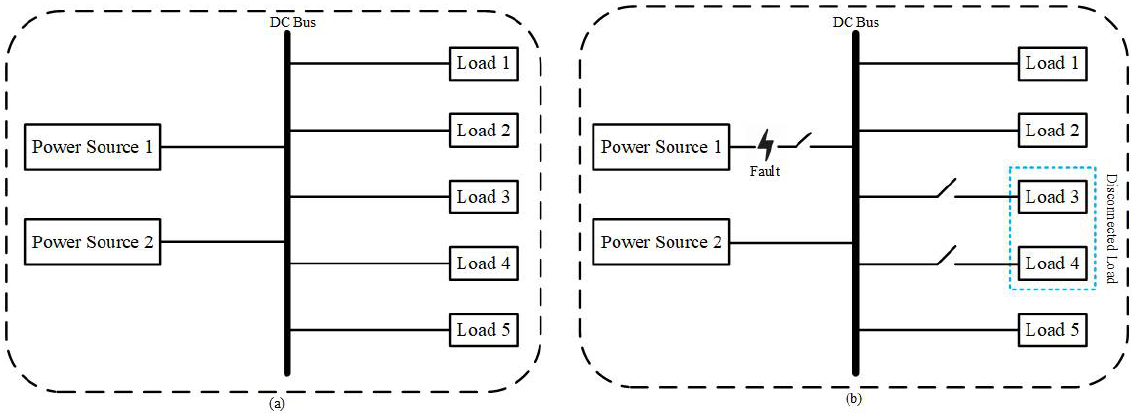
Figure 16. ( a ) Normal operation; ( b ) operation during fault condition.